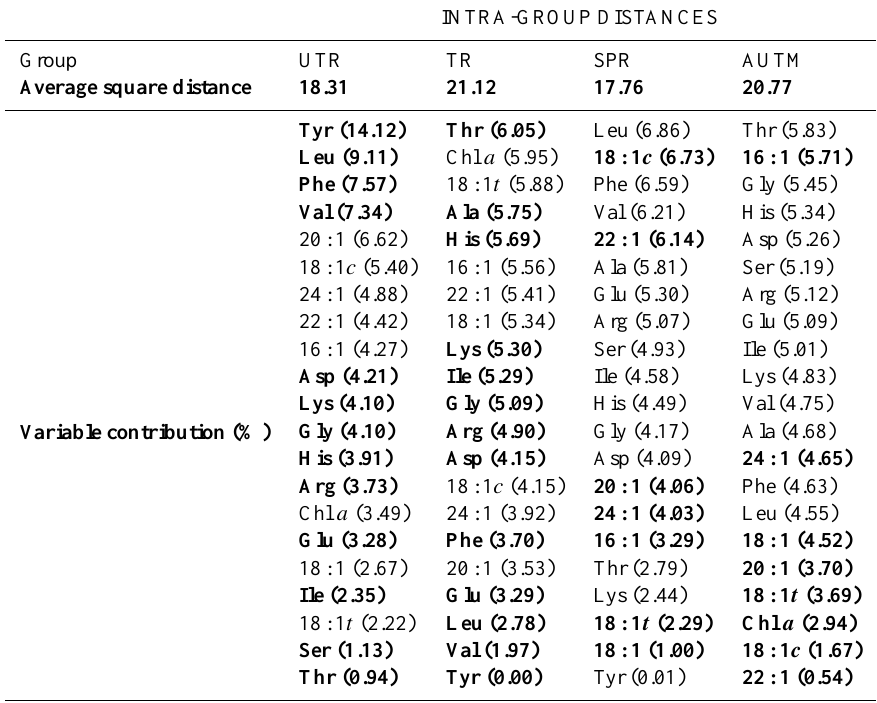
Table 4a. Results of the multivariate statistical test SIMPER carried out on those biomarkers which better evidenced differences between sampling seasons (Chl a and MUFA) and between trawling regions (protein and neutral THAA). Intra-group distances within the a priori- defined groups UTR, TR, SPR and AUTM.